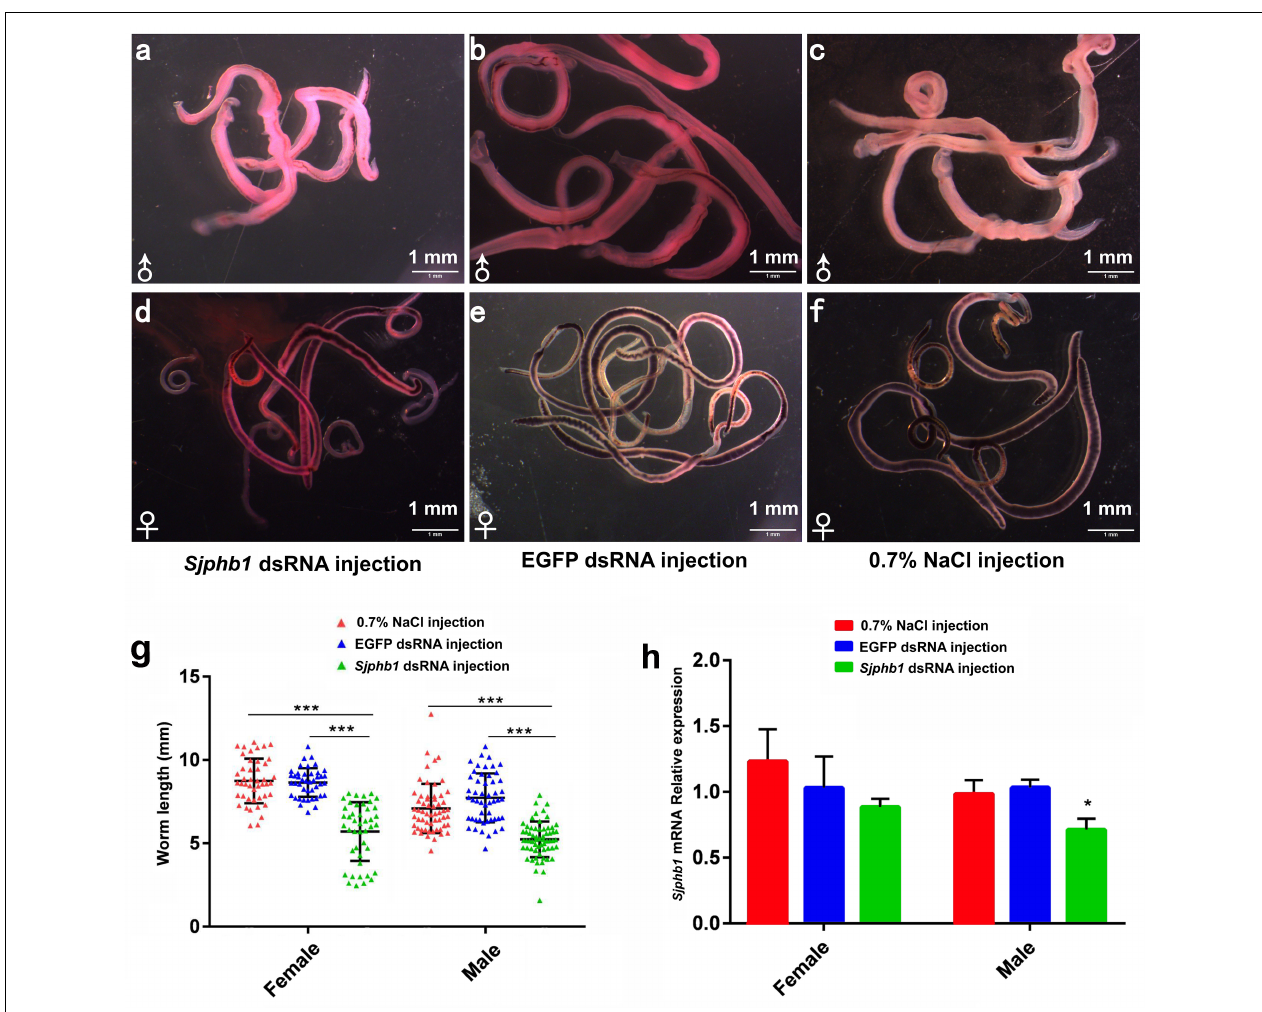
FIGURE 9 | SjPhb1 dsRNA-mediated knockdown in vivo negatively affected the growth of schistosome worms in their mammalian host. (a–c) Male worms collected at 42 days post-infection (dpi). (d–f) Female worms collected at 42 dpi. (a,d) SjPhb1 dsRNA-treated worms. (b,e) EGFP dsRNA-treated worms. (c,f) 0.7% NaCl-treated worms. (g) Worm length comparison. (h) Efficiency assessment of the dsRNA-mediated SjPhb1 knockdown by quantitative RT-PCR. ∗ P < 0.05, ∗∗∗ P <